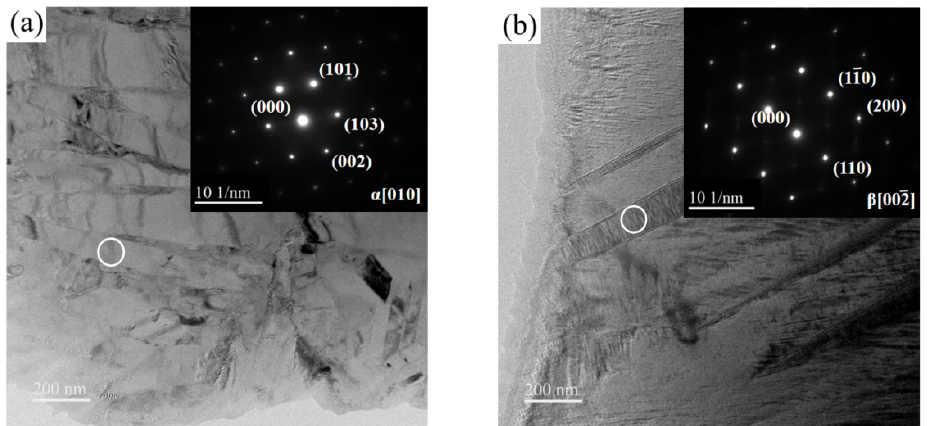
Figure 7. TEM morphology and selected area electron diffraction pattern: ( a ) α phase; ( b ) β phase.